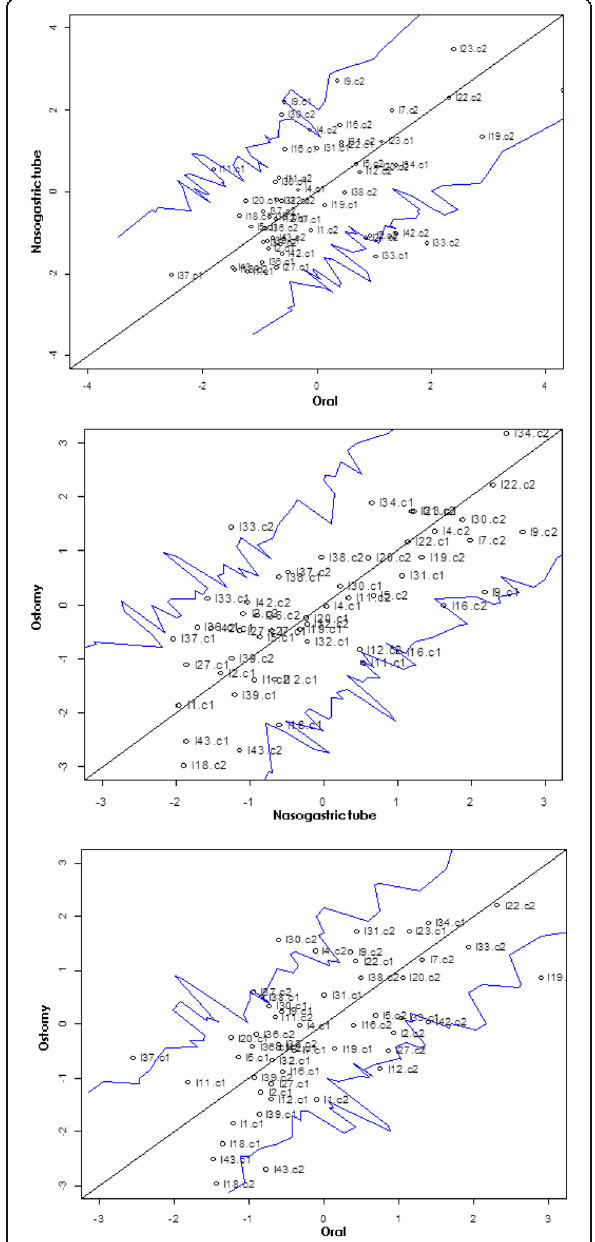
Fig. 3 Differential item functioning in groups defined by administration route (nasogastric tube vs. oral, ostomy vs. nasogastric tube and ostomy vs.